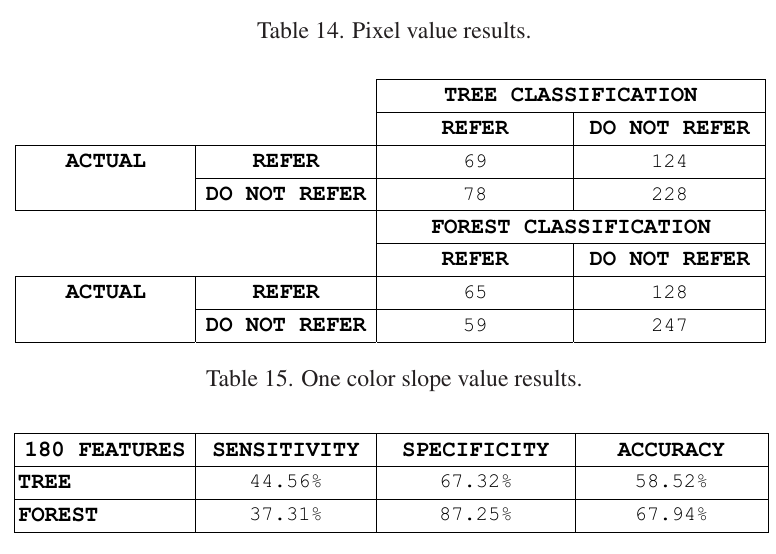
Table 16. Pixel value metrics.